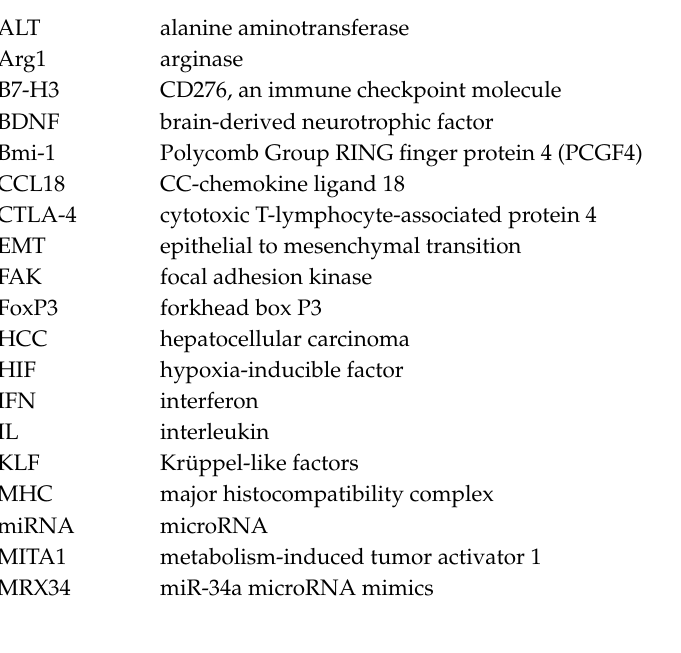
Figure S1: PRISMA 2009 Flow